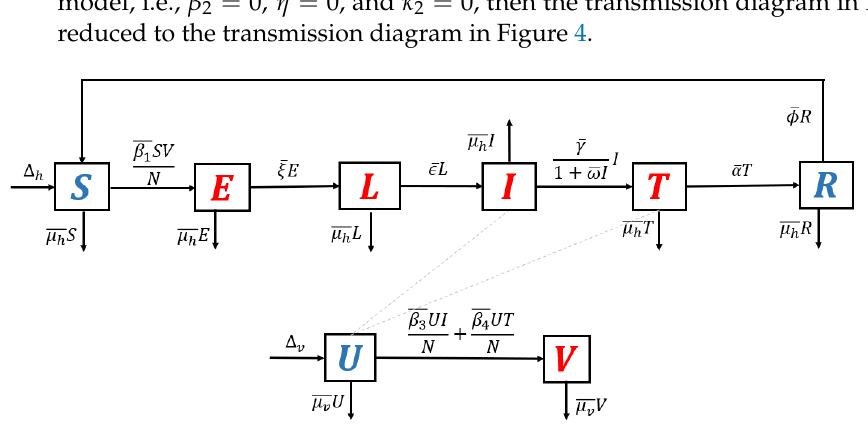
Figure 4. Transmission diagram of malaria disease without any recurrence phenomena.